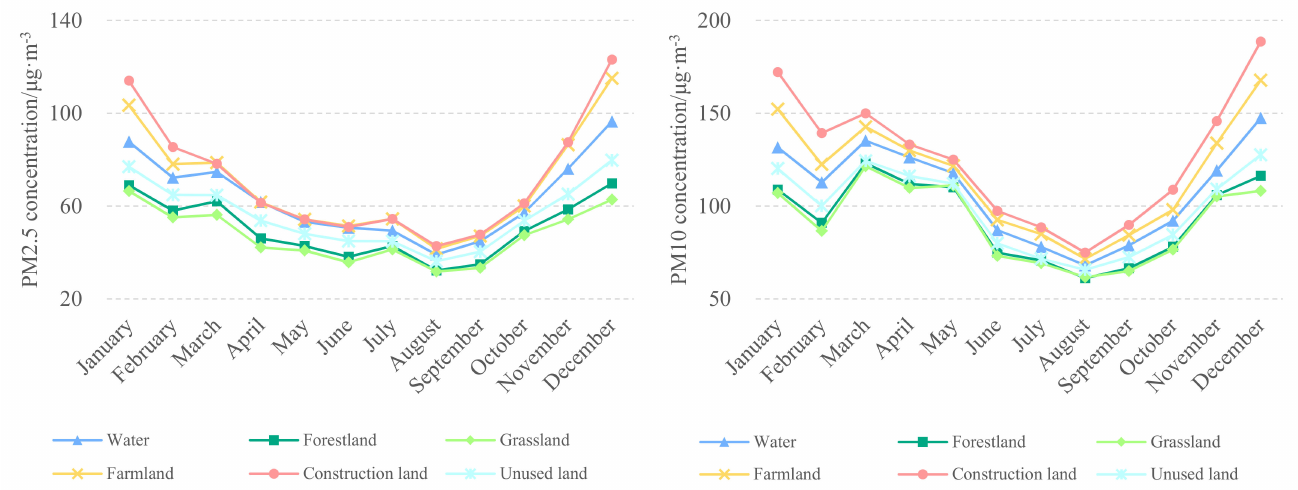
Figure 5. Monthly mean values of the PM 2.5 and PM 10 concentrations corresponding to each land use